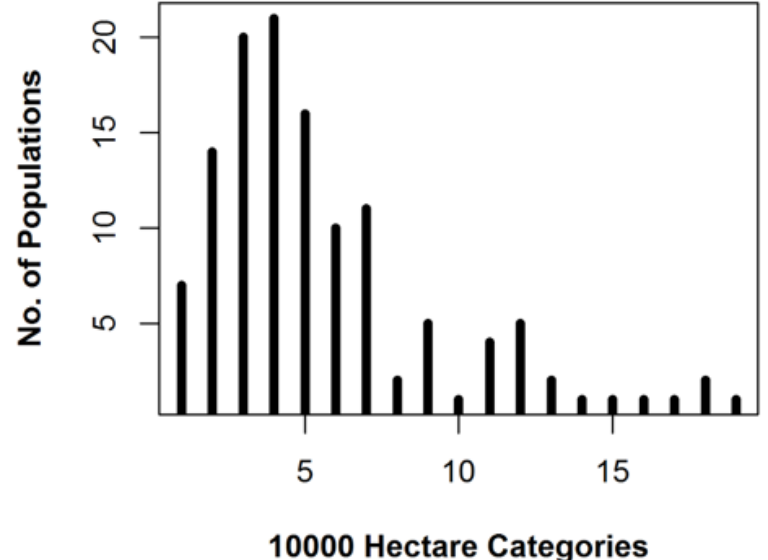
Figure 4. The distribution of population sizes for the 125 populations in the simulation in categories rounded up to the nearest 10,000 Hectares.